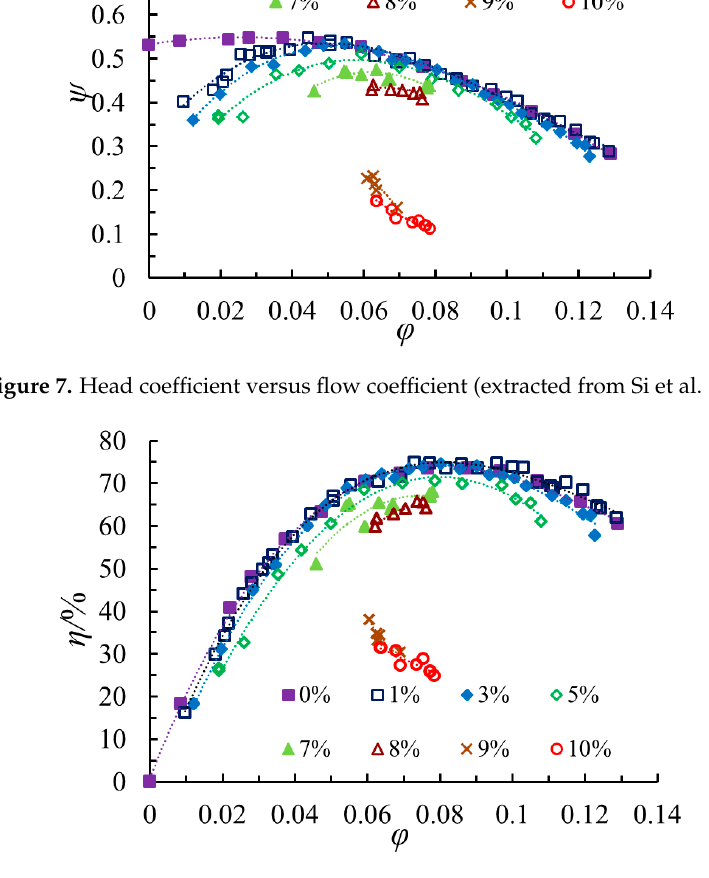
Figure 8. Efficiency versus flow coefficient (extracted from Si et al. [24]).